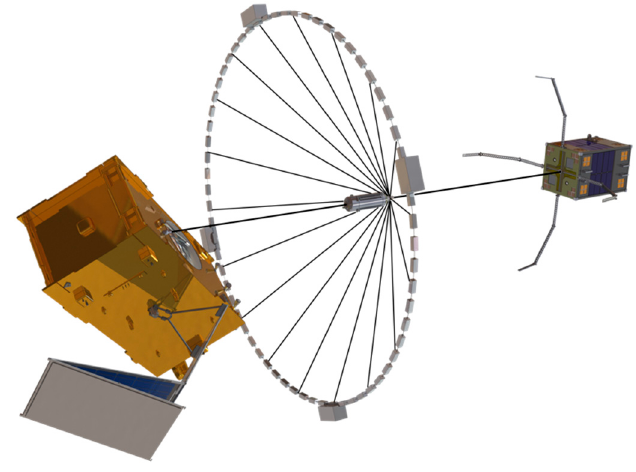
Figure 9. A servicing satellite conducting the capture operation.